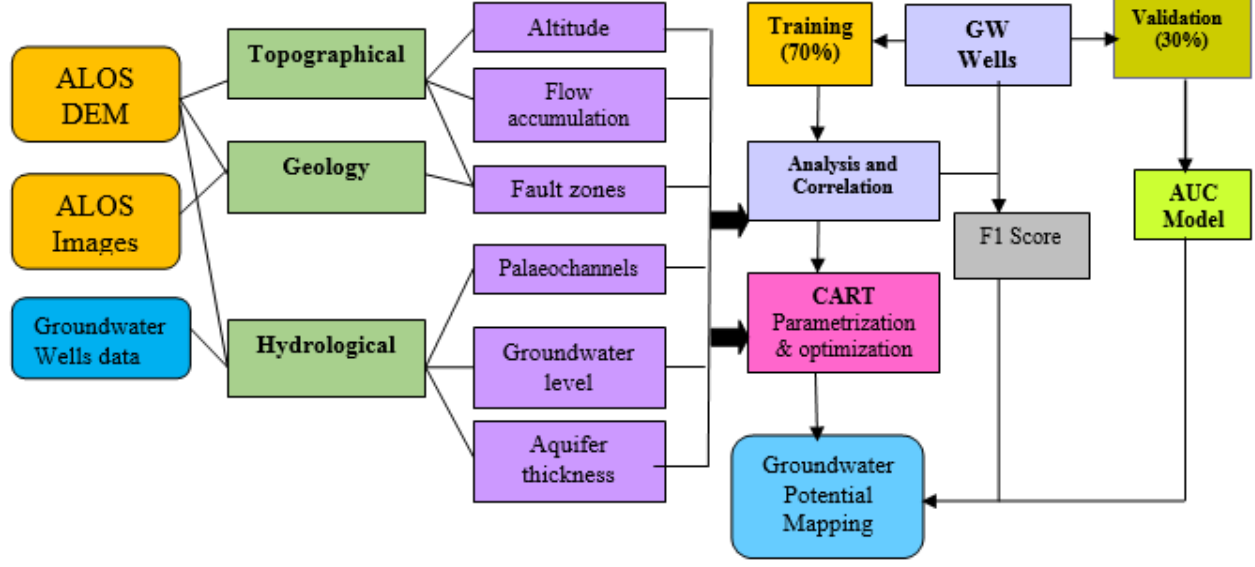
Figure 4. Flowchart of the methodology.